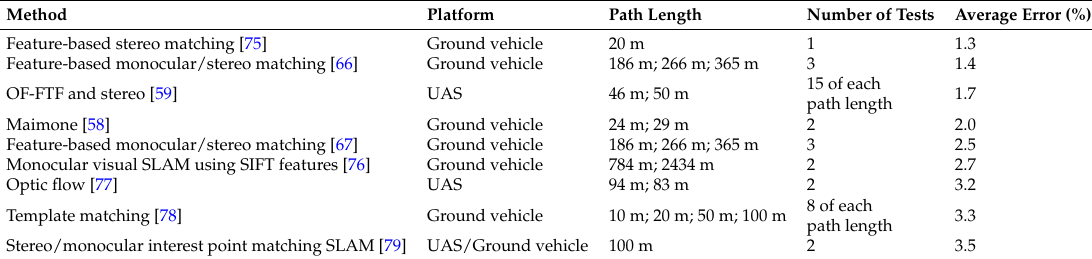
Figure 6. Trajectories of 30 flights (two sets of 15 flights) traversing a 10 × 10 m square at a height of 3 m ( a ) or 5 m ( b ). Various trajectory colors are used to differentiate the individual experiments. Landing positions are shown by the green points within each inset, which are relative to the takeoff position. The red point denotes the mean landing position for 3 and 5 m test heights respectively. Modified with permission from [59]. Table 2. Comparison of various visual odometry